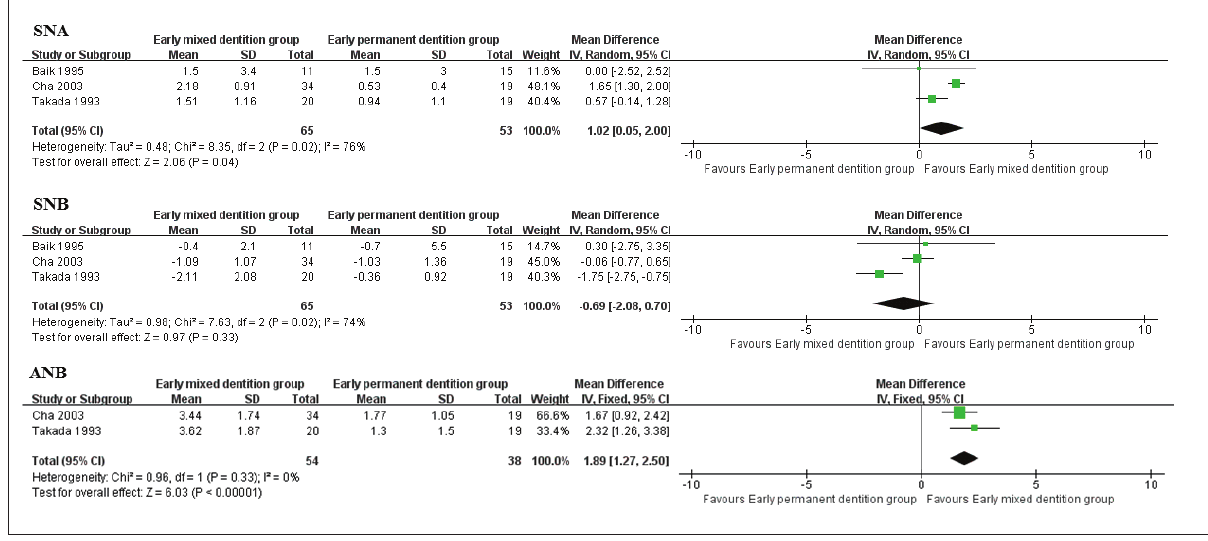
Figure 5. Meta-analysis between early mixed dentition and early permanent dentition. The efficacy assessment of the early mixed dentition group for Class III malocclusion versus the early permanent dentition group. The comparison was per- formed using three indices. 1: Angle SNA. The early mixed dentition group presented a greater increase in SNA than the early permanent dentition group (MD = 1.02, 95% CI = 0.05 – 2.0, P = 0.04). 2: Angle SNB. There were no significant differences in SNB between the two groups (MD = -0.69, 95% CI = -2.08 – 0.70, P = 0.33). 3: Angle ANB. The early mixed dentition group presented a greater increase in ANB than the early permanent dentition group (MD = 1.89, 95% CI = 1.27 – 2.50, P <